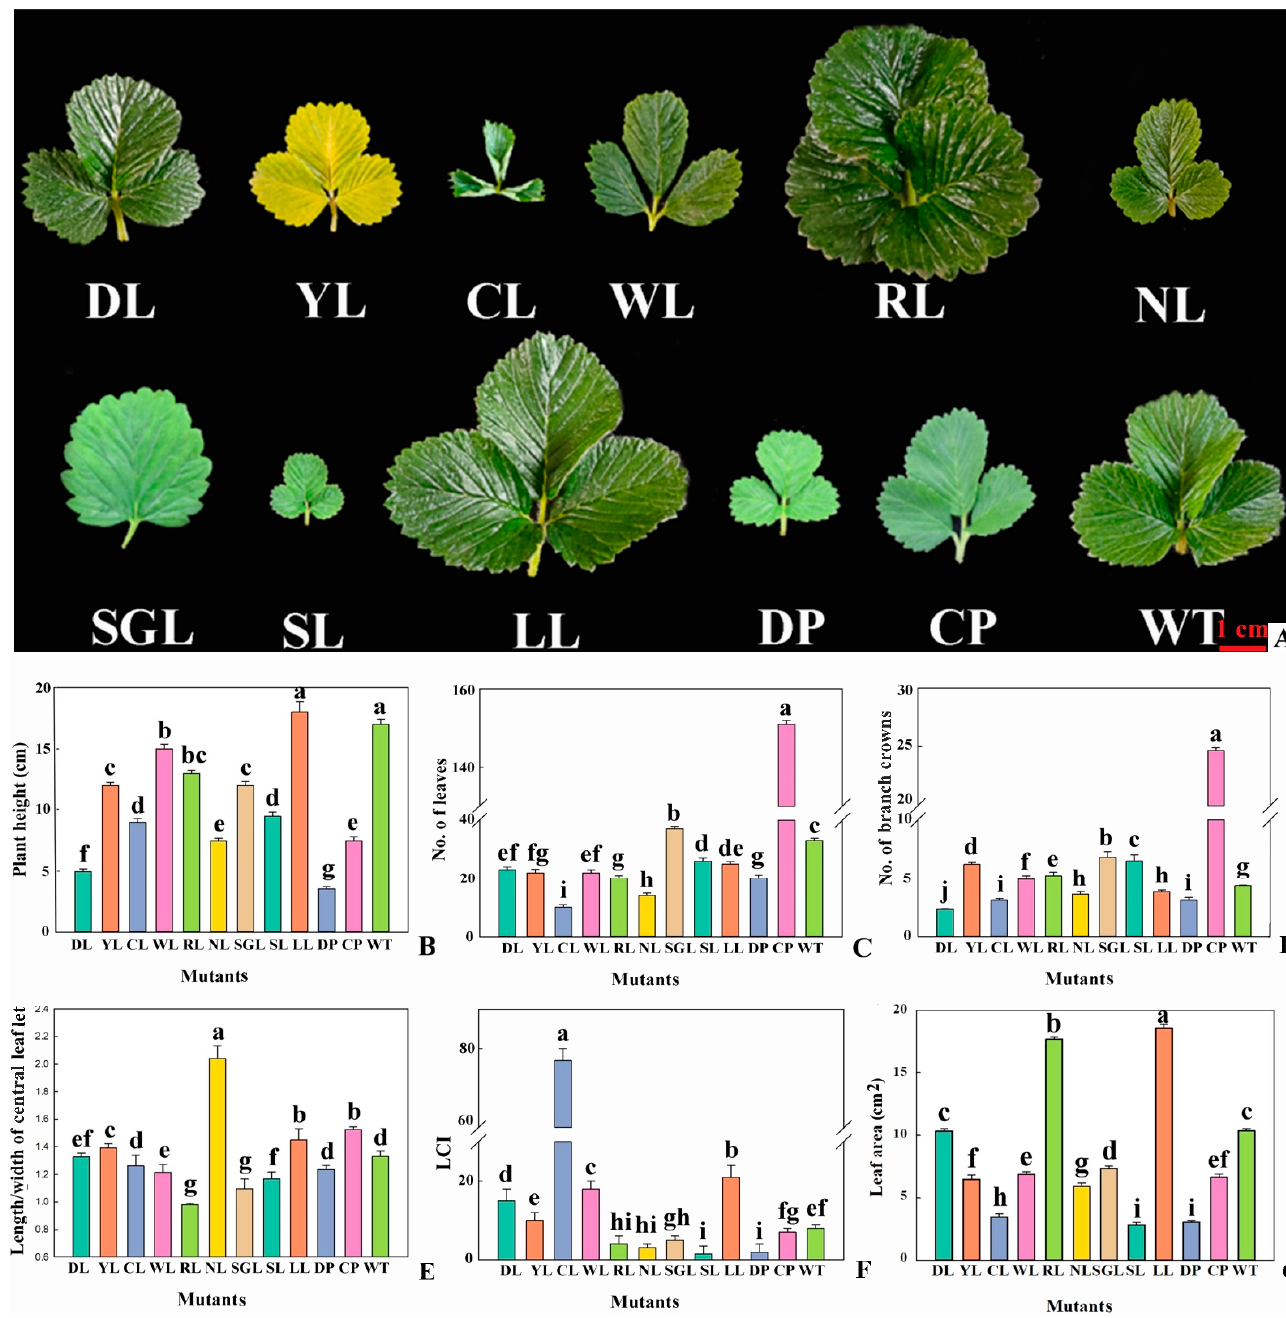
Figure 3. The plant and leaf traits of 11 mutants in F. nilgerrensis . ( A ) Leaves; ( B ) plant height; ( C ) No. of leaves; ( D ) No. of branch crowns; ( E ) leaf length/width; ( F ) LCI; ( G ) leaf area. Abbreviated letters of mutants were described in Figure 2. Bars indicate S.E. of means, and different lowercase letters indicate significant differences among treatments according to LSD test ( p < 0.05). Scale bar = 1 cm.